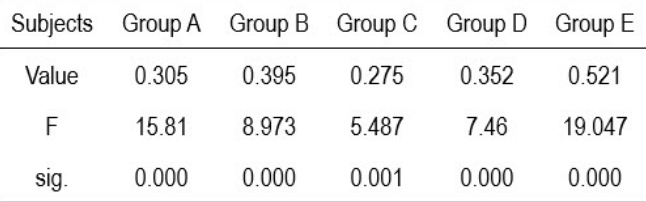
Multivariate test by Pillai’s Trace method